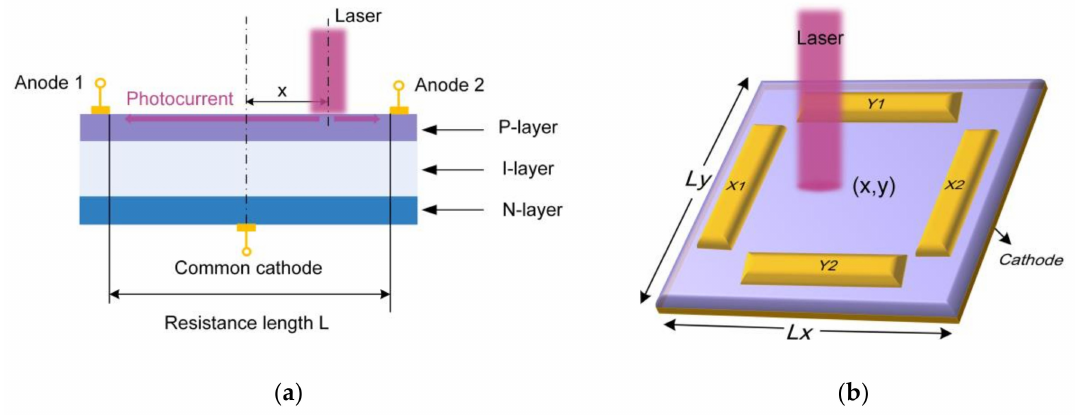
Figure 1. Working mechanism of PSD: ( a ) the cross-section of a one-dimensional PSD; ( b ) schematic diagram of two-dimensional tetra-lateral